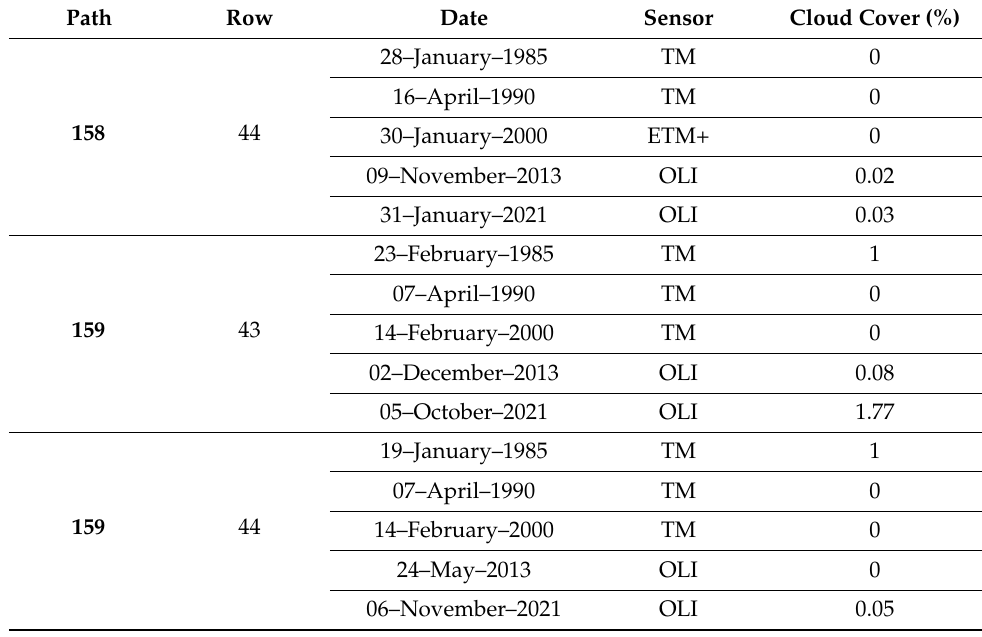
Figure 2. Flowchart illustrating the steps of satellite data analyses in the study area. Table 1. Information from Landsat images used in this research. Path